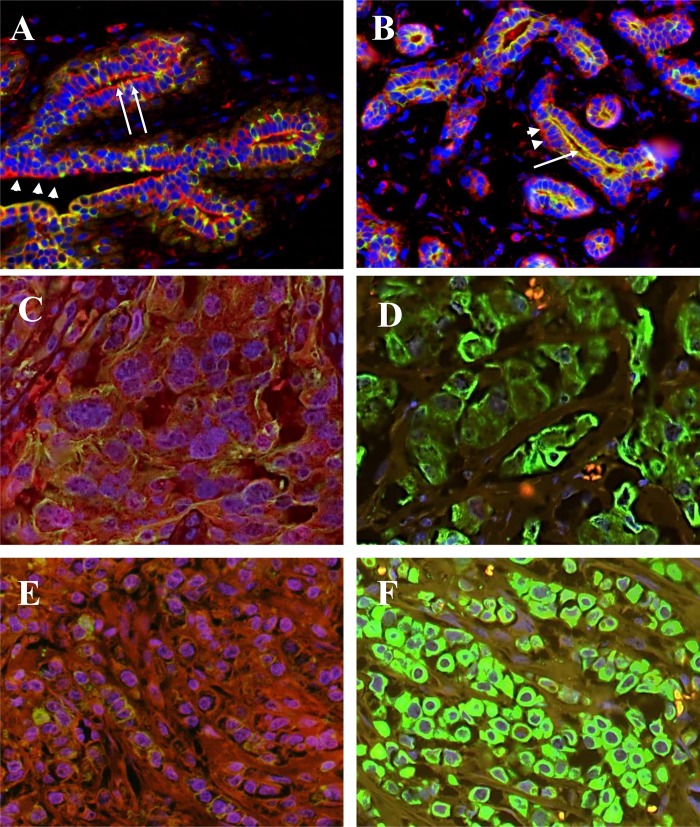
Dual IF staining for BRCA1 and CK8/18 in representative cases of invasive breast cancer and normal breast tissues.A and B: Normal breast ducts and glands with positive red IF for BRCA1 in myoepithelial cells (arrowheads) and luminal cells (arrows). C: BRCA1 positive ductal carcinoma. D: BRCA1 negative ductal carcinoma. E: BRCA1 positive lobular carcinoma. F: BRCA1 negative lobular carcinoma.